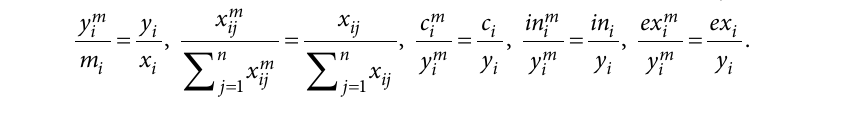
Table 1. Simplified regional input-output table